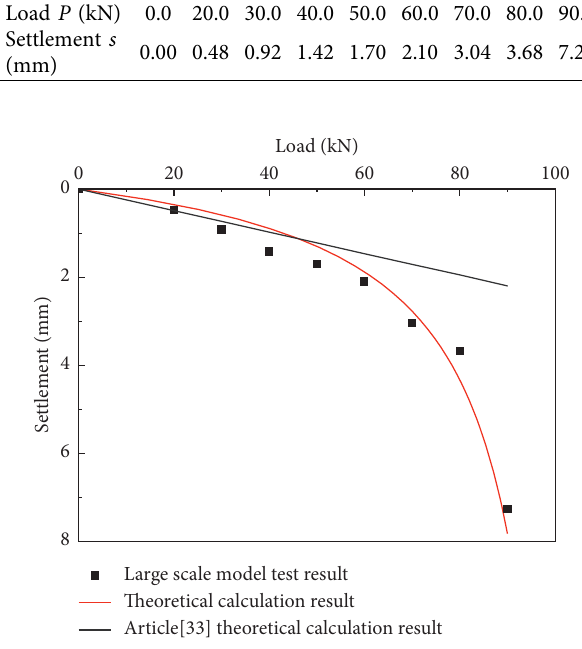
Figure 5: Comparison of the pile